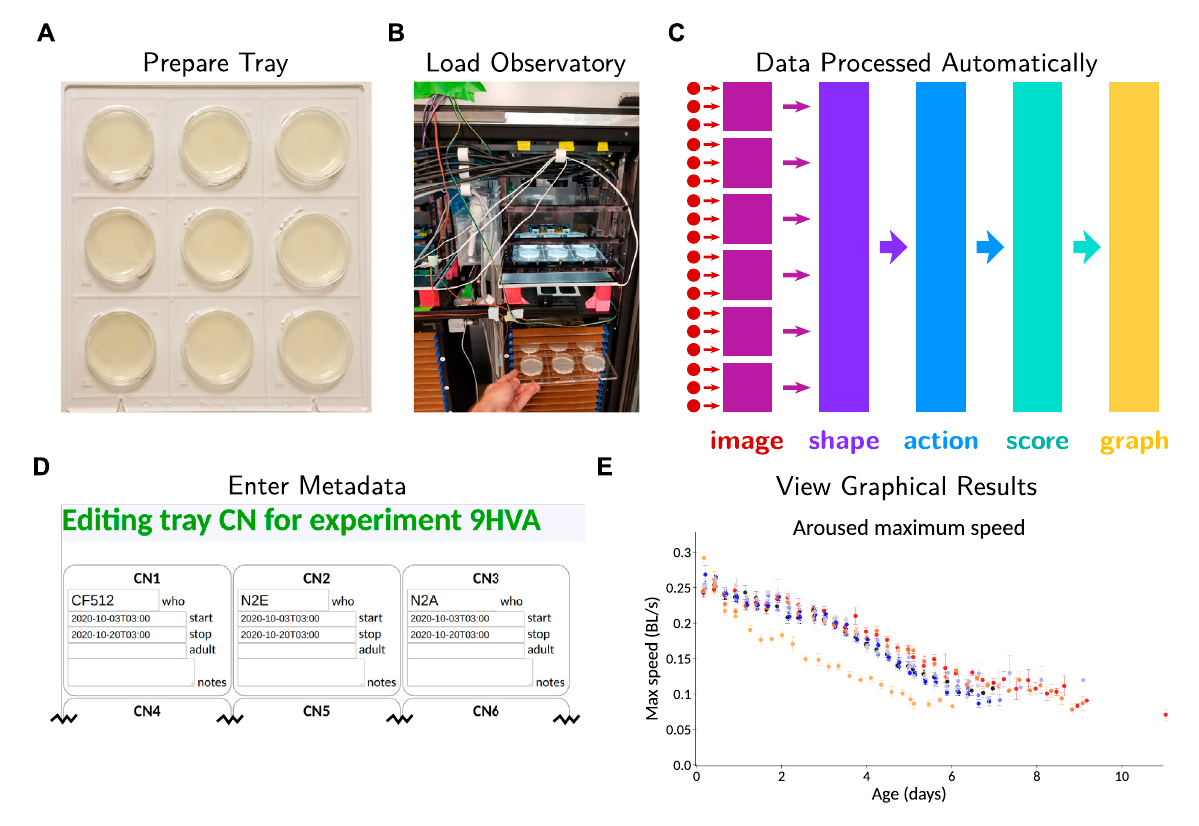
FIGURE 1 Overview of operating the C. elegans Observatory. (A) Sample preparation. Worms on standard plates are placed in laser-cut acrylic trays. (B) Instrument loading. Trays are placed in a tower in the C. elegans Observatory, which automatically cycles the trays for imaging four times a day. (C) Data processing pipeline. Triplets of cameras (red dots) send images to six computers (purple squares) for real-time image analysis. Shapes and positions are extracted and sent to a central server (indigo); from these, successive processing steps extract timecourses of behavioral parameters(lightblue),per-animalhealthscores(teal),and fi nally,graphsofbehaviorovertime(gold).Allanalysishappensautomaticallywithnouser intervention necessary. (D) Metadata entry. Users enter metadata identifying what sample is on each plate. (E) Online graphical results. Metadata is used to group samples and present graphs to users on request as data becomes